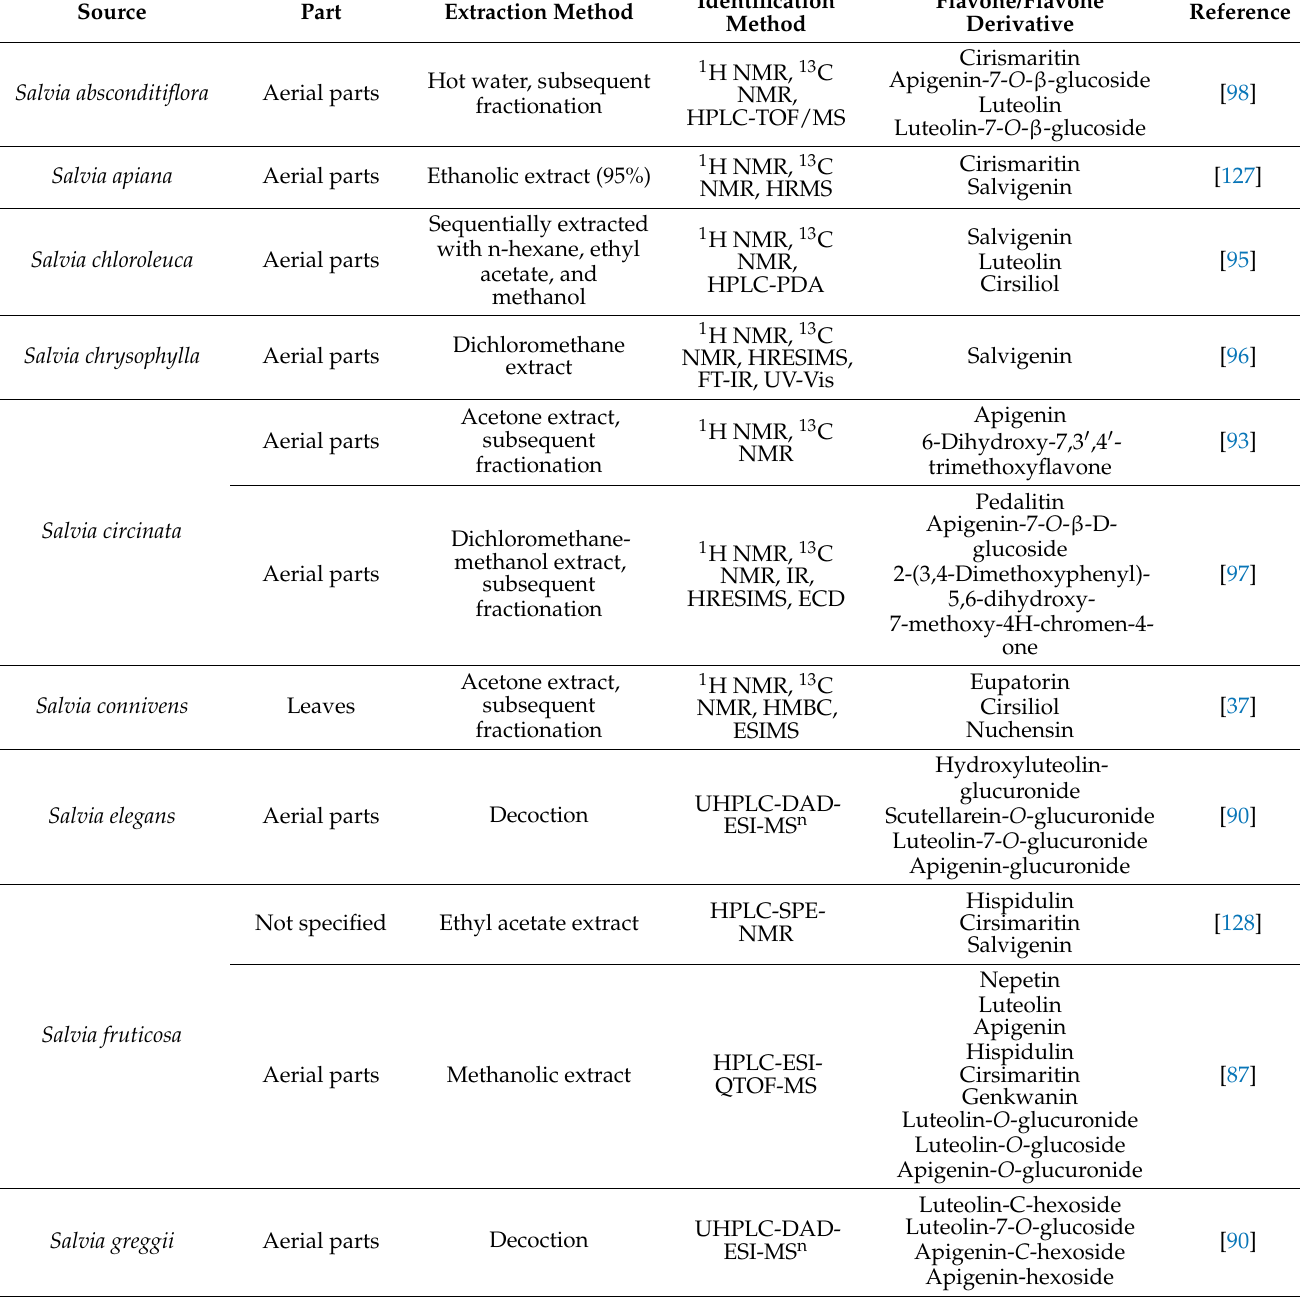
Table 3. Conventional solvent extraction methods of flavones from Salvia , Ocimum , Origanum , and Thymus